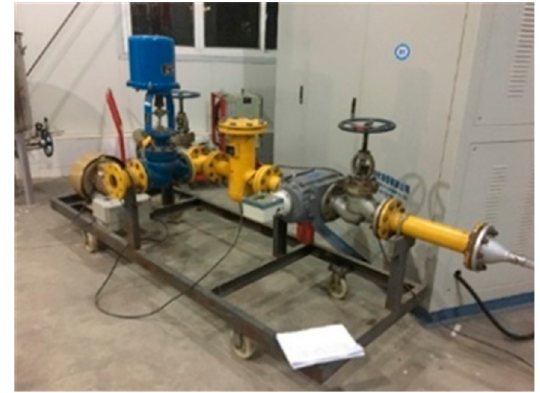
Figure 5. Air supply unit.